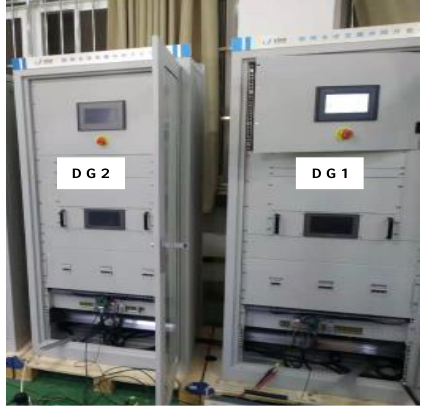
Figure 8. The experimental platform of a two-machine parallel